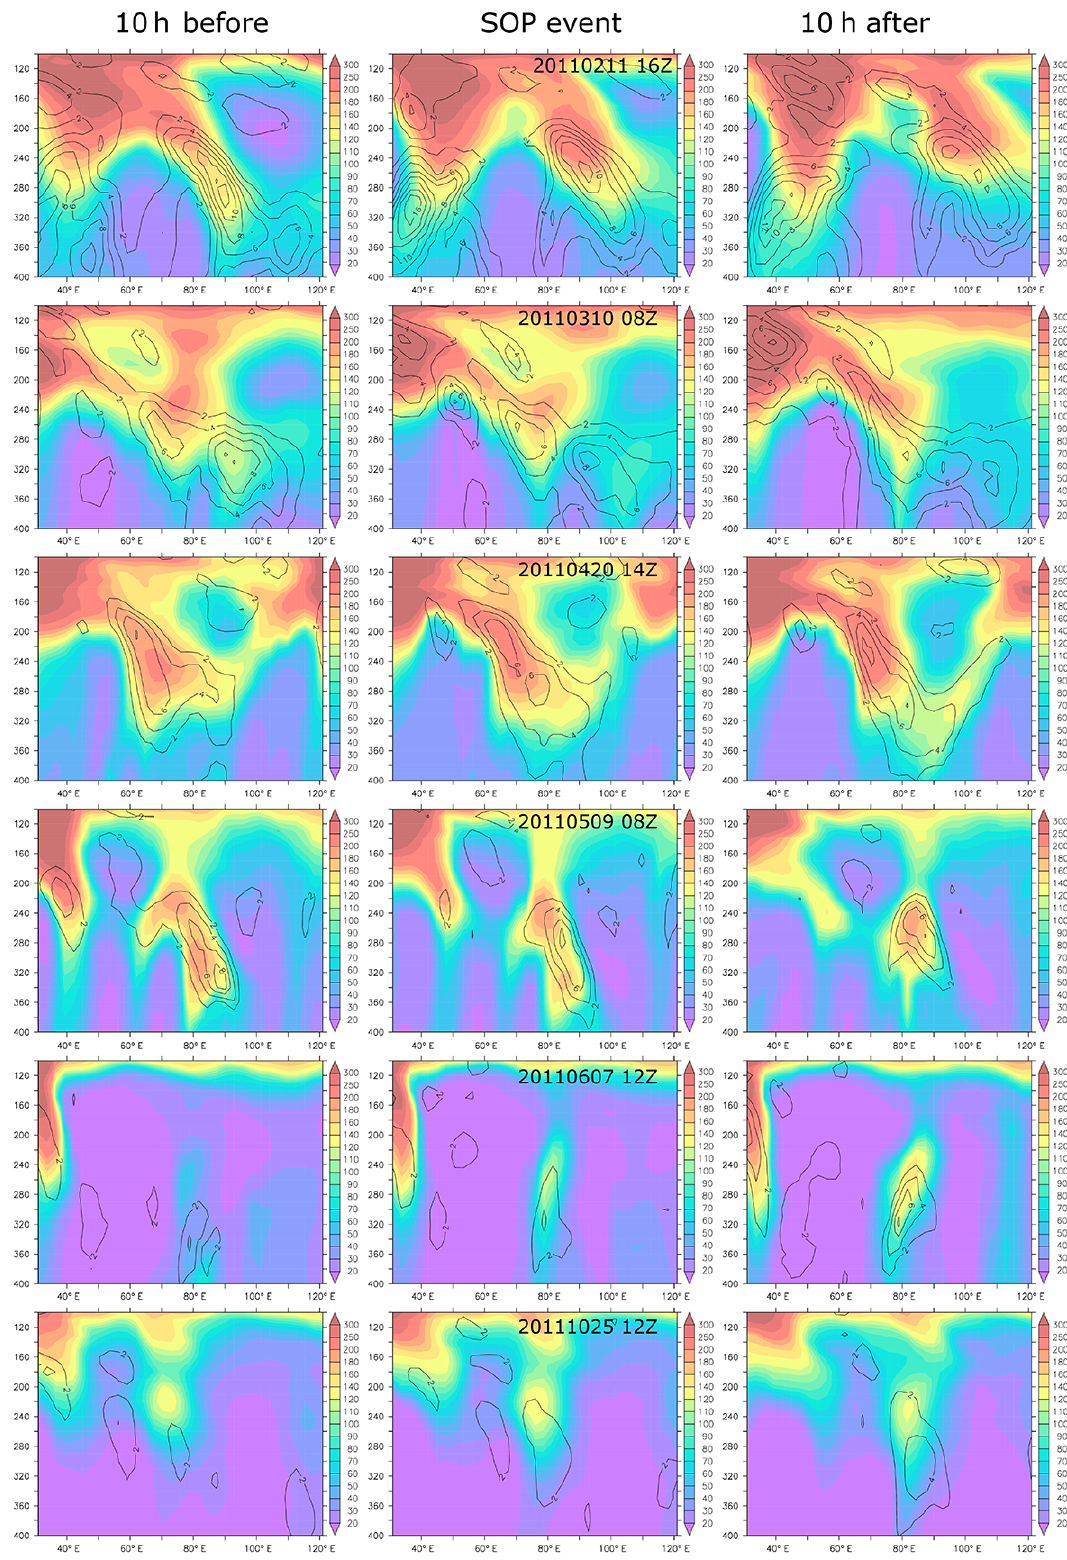
Figure 10. The longitude-pressure cross section of O 3 s (colour filled), and turbulence index (TI) (contour lines) (in 10 − 7 s − 2 ) at 29.5 ◦